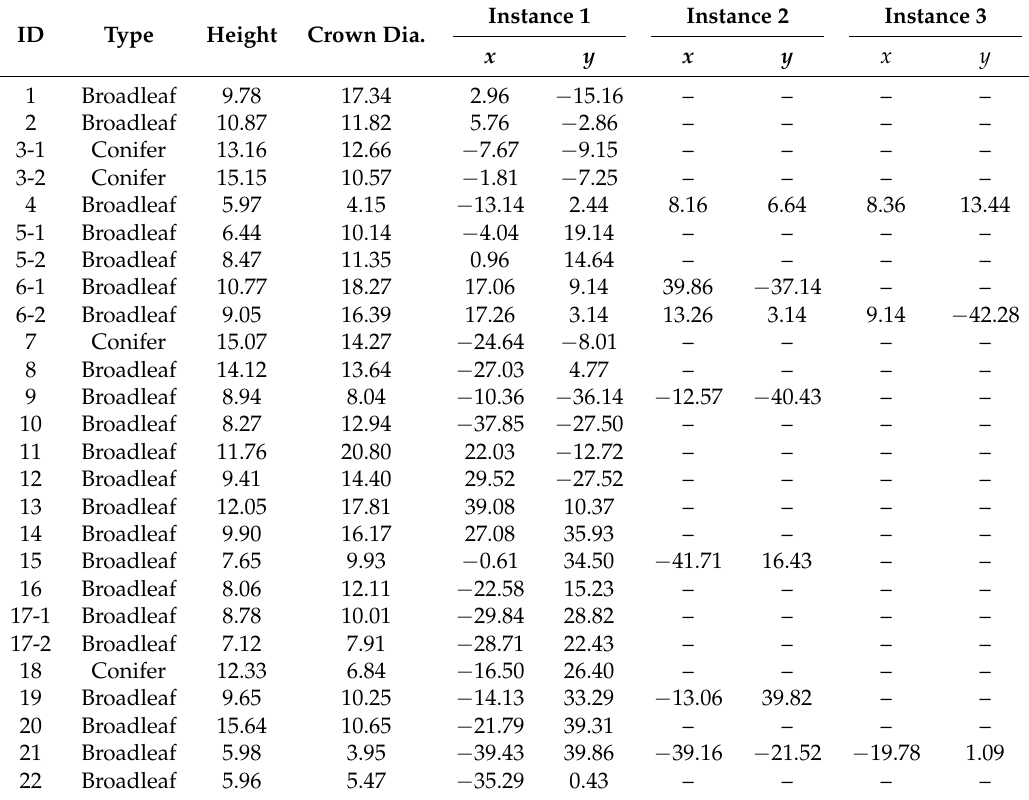
Table 2. List of tree models in the plot #116 scene (unit: meter). The positions are in scene East North Up (ENU) coordinates from the center of the plot (37 ◦ 06 (cid:48) 43.77 (cid:48)(cid:48) N, 119 ◦ 44 (cid:48) 11.85 (cid:48)(cid:48)